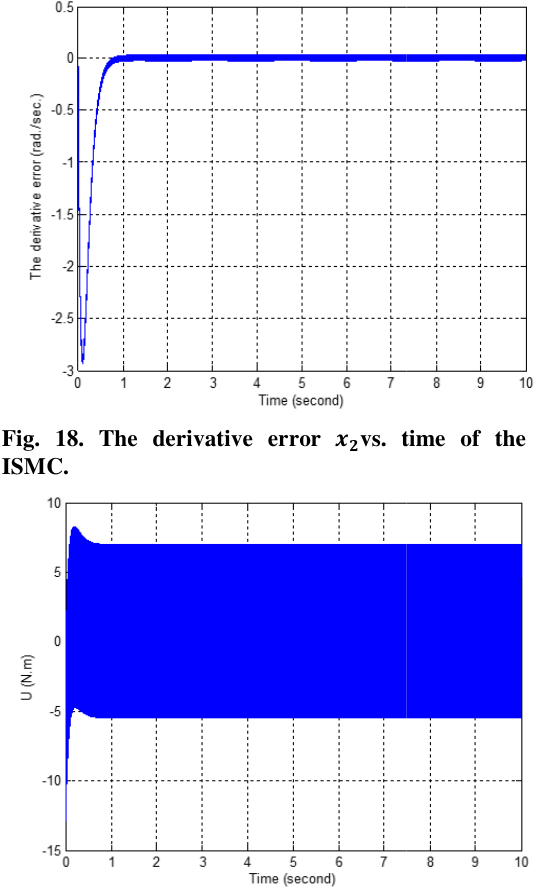
Fig. 22. The plot of the Sliding variable S and the The plot of the Sliding variable S and the Fig. 19. The control action c vs. time of the ISMC. vs. time of the ISMC. Integral term e vs. time of the ISMC vs. time of the